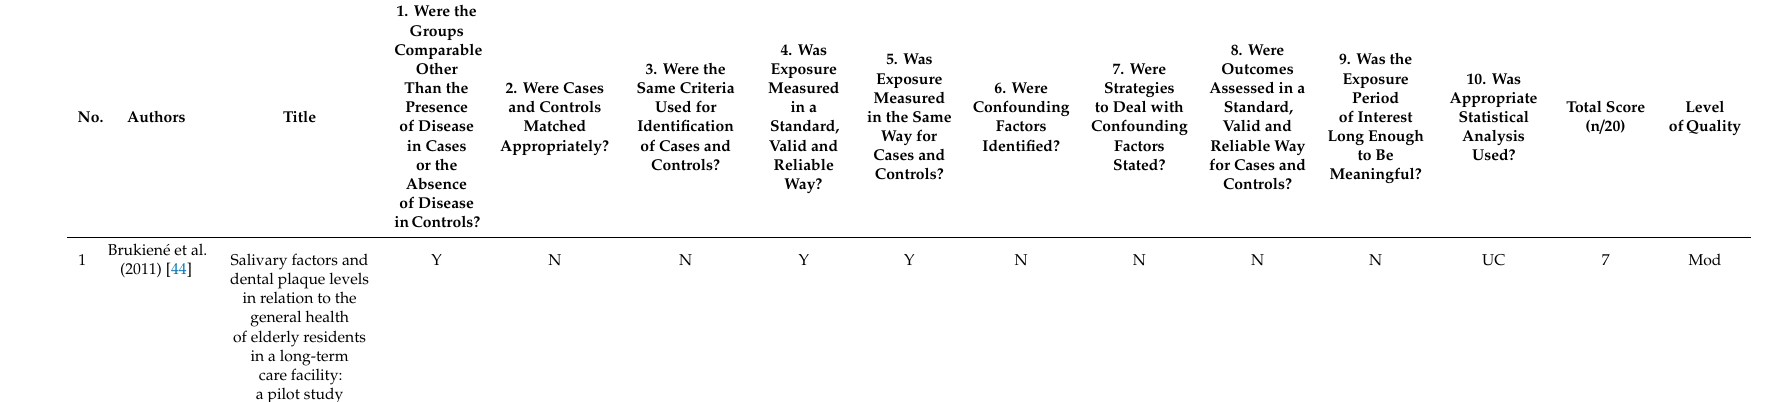
Table 2. Methodological quality for case control